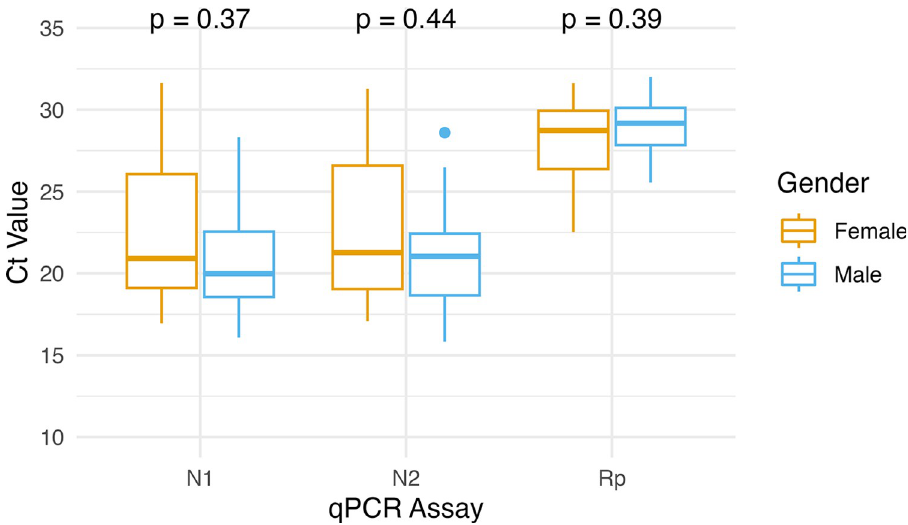
Fig 3. Comparison of mean Ct values by gender for each assay. Box and whisker plots for each qPCR assay by gender. Whiskers indicate maximum and minimum Ct value for each cohort. Horizontal line within box indicates mean Ct value. Dots indicate outliers. P-values of each comparison are indicated above the appropriate